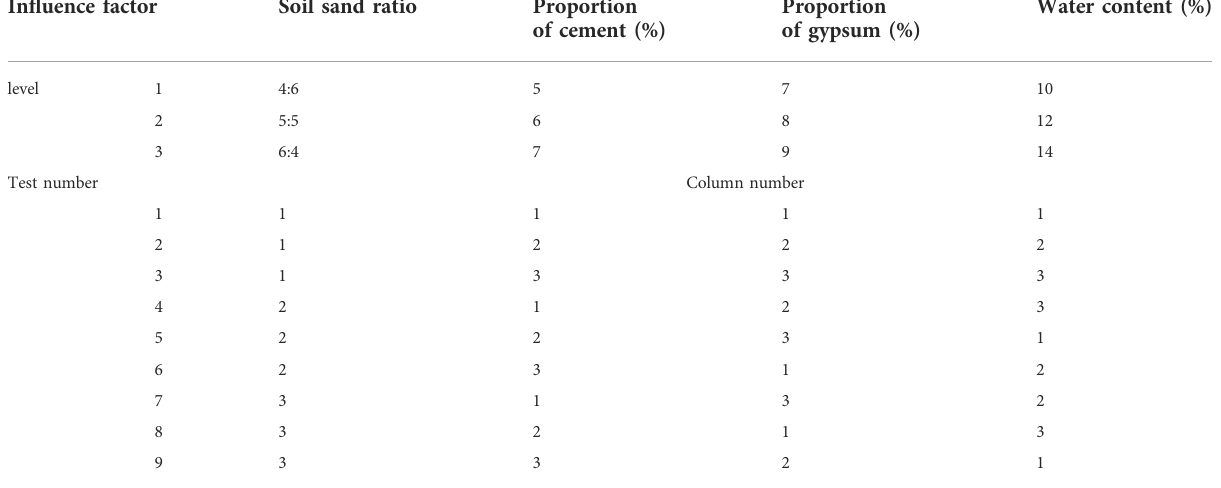
TABLE 2 Orthogonal test design